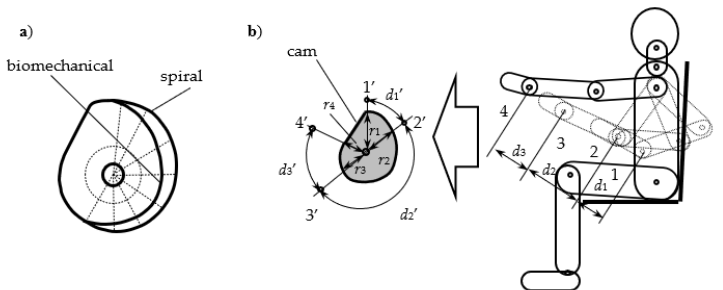
Figure 2. Cams: ( a )—spiral and biomechanical; ( b )—the idea of a biomechanical cam (designations: 1, 2, 3, 4—successive limb positions when pulling the propelling cable; 1 ′ , 2 ′ , 3 ′ , 4 ′ —successive points for building the cam geometry; d 1 , d 2 , d 3 —distances obtained when pulling the propelling cable; d 1 ′ , d 2 ′ , d 3 ′ —distances corresponding to d 1 , d 2 , d 3 measured along the curve; r 2 , r 3 , r 4— cam radii).